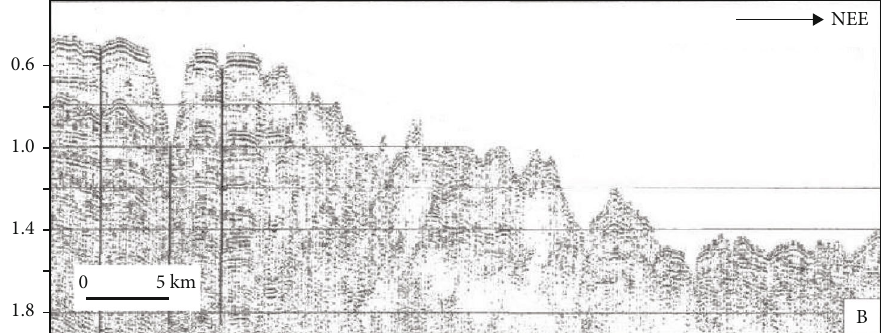
Figure 23: Typical seismic pro fi les of turbidity in the East China Sea slope area (Zhao et al.